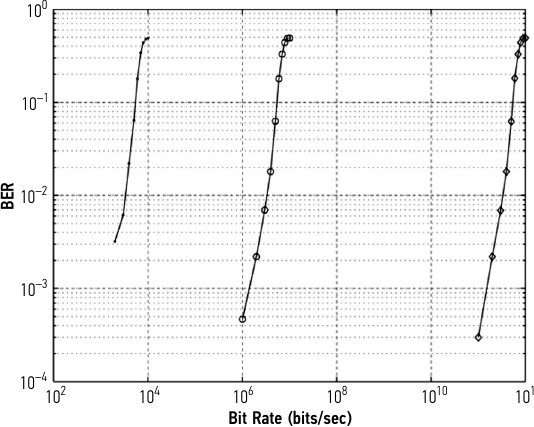
Fig. 8. Dependence of error probability for a BPSK modulation scheme on data transmission rate: free space path loss 180 dB (dots), 150 dB (circles), 100 dB (diamonds); with convolutional coding (rate 3/4, constraint length K = 7); receiver noise temperature is 290 K; phase and frequency offsets are equal to zero; HPA back-off level is 7 dB; satellite phase noise is negligible; antennas gain G = 1